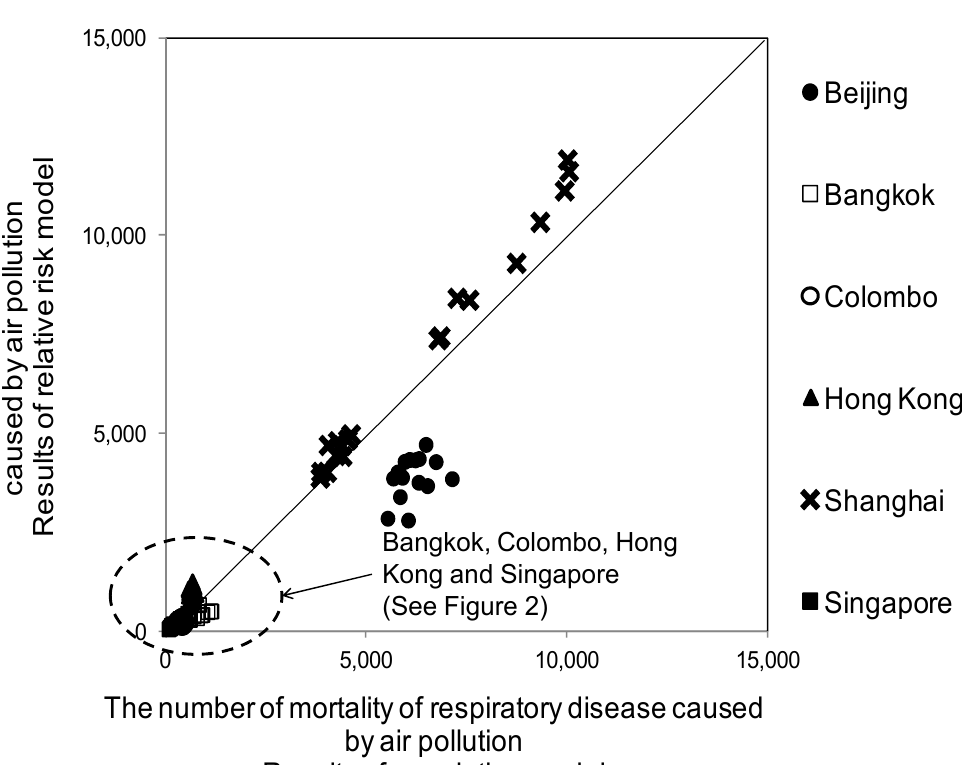
Figure 1. Overall comparison of the results from the two models.